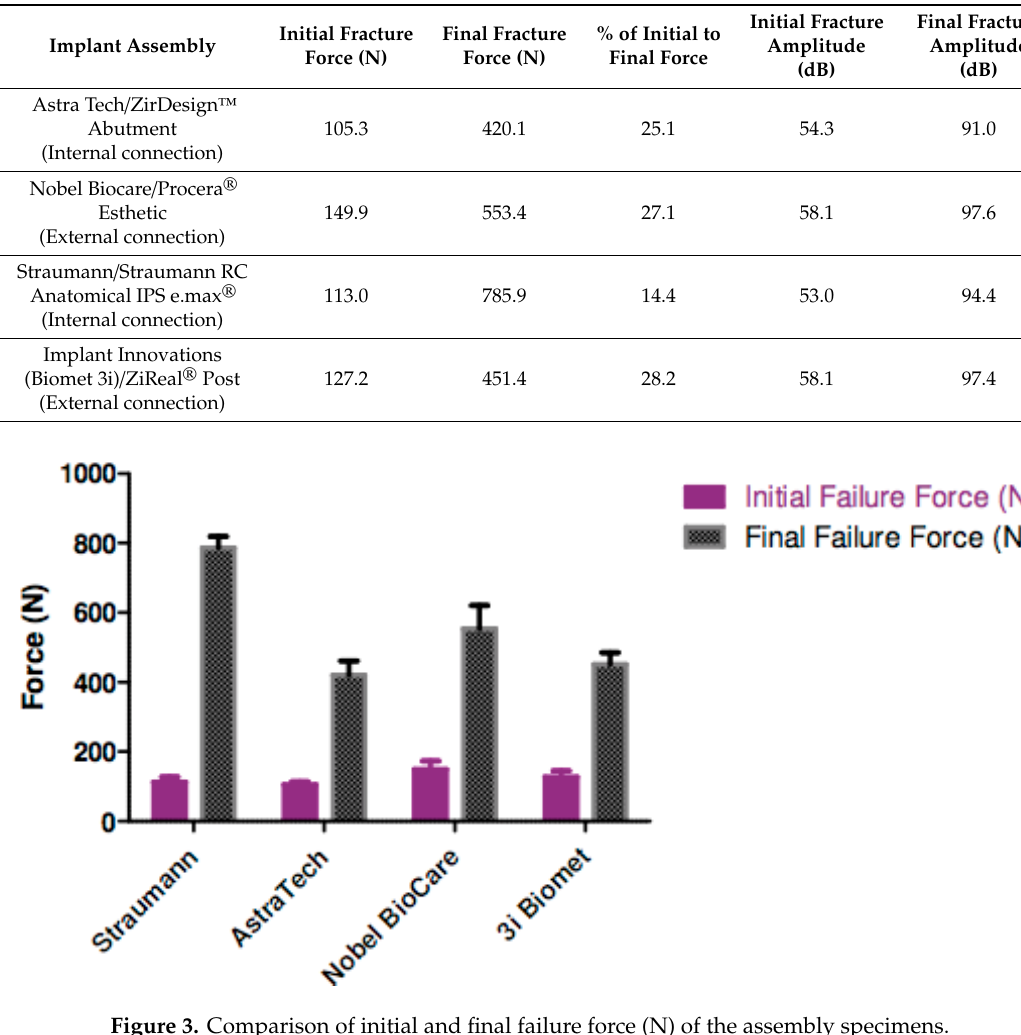
Figure 3. Comparison of initial and final failure force (N) of the assembly specimens.